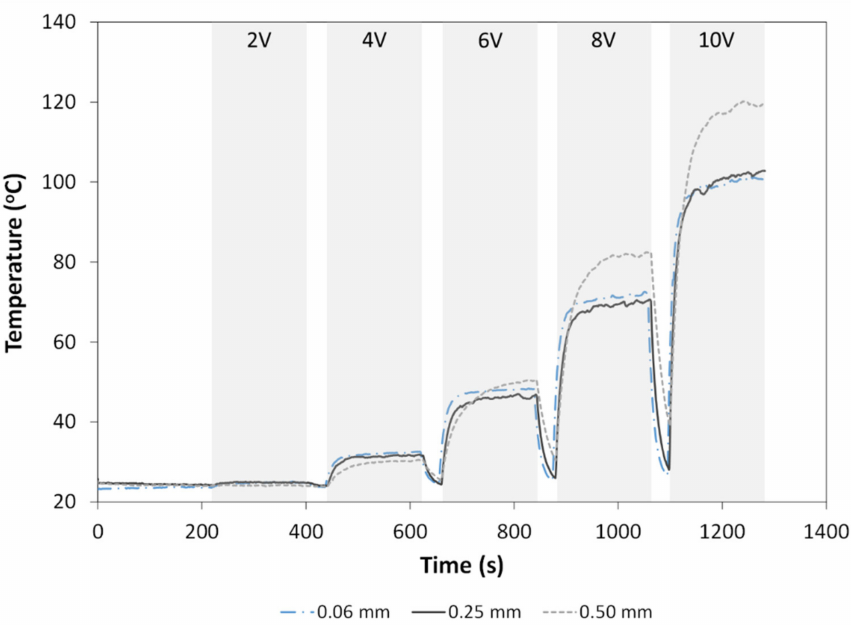
Figure 8. Representative temperature profiles measured for 25 wt.% MWCNT/PP films when voltages from 2 V to 10 V are applied for three minutes